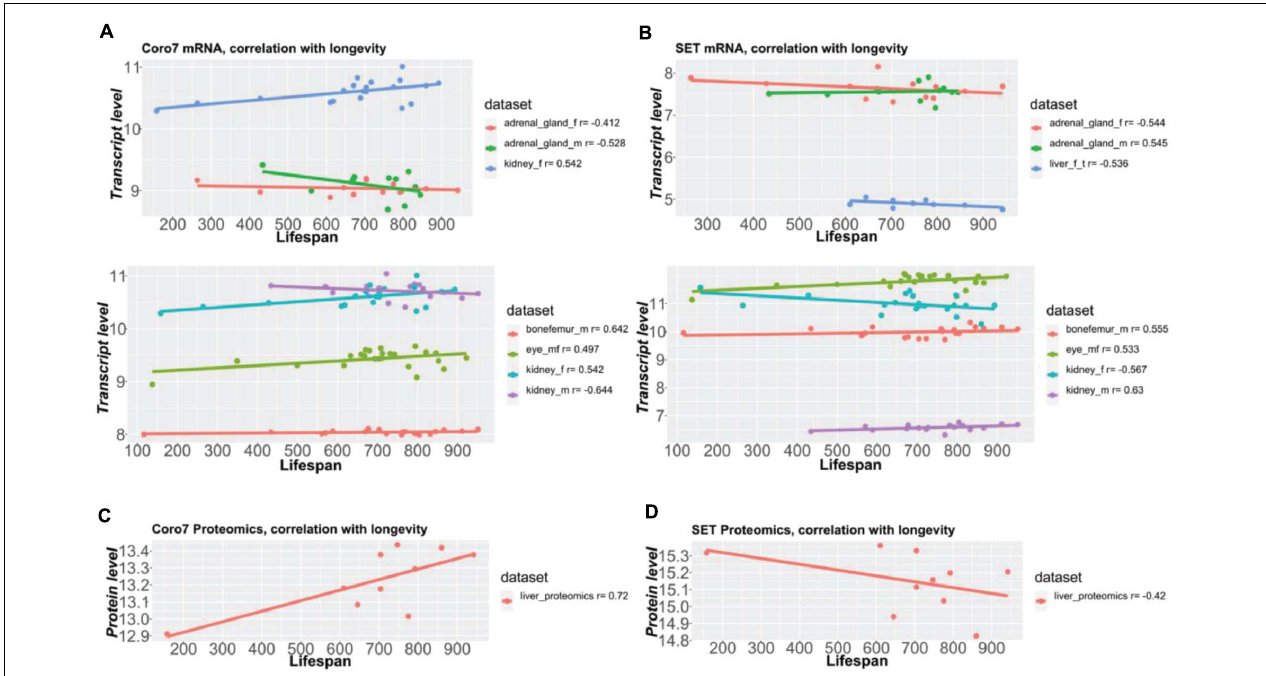
FIGURE 6 | Coro7 and Set gene expression correlate with lifespan across tissues. Coronin 7 (A,C) and SET nuclear oncogenes (B,D) were identified as the only two pervasive longevity genes, across all eight datasets with a longevity score (absolute Pearson’s r ) ≥ ± 4, SET being the best longevity-correlated gene (0.53 < | r | < 0.63 across tissues), followed by Coronin-7 (0.41 < | r | < 0.64 across tissues). The Y -axis values represent normalized values ( A,B : bottom parts) via RMA (except bone femur, normalized via VST + RSN) or 2z + 8 scores ( A,B , upper parts, C,D ) (see Supplementary Table 1